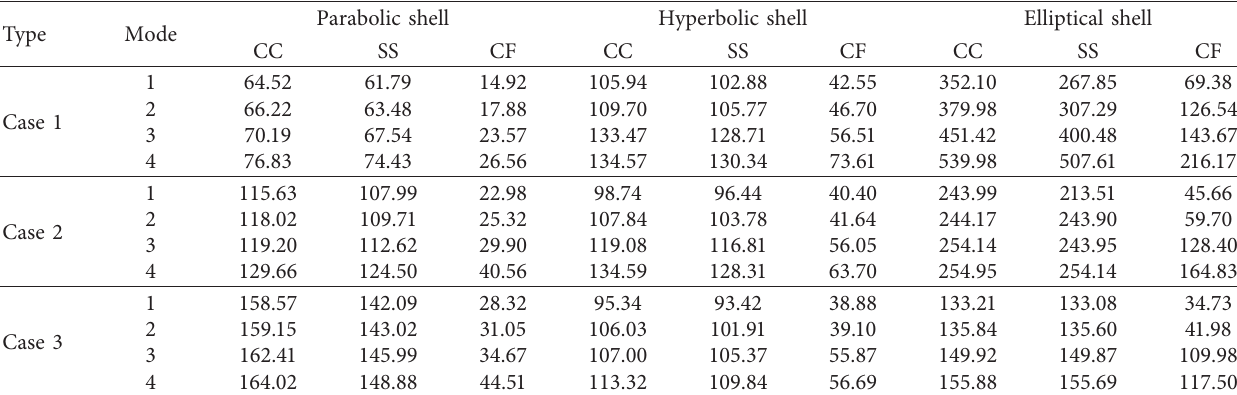
Table 7: First four frequencies for Type 1-2 Sandwich FGP doubly curved structure with diverse boundary conditions.